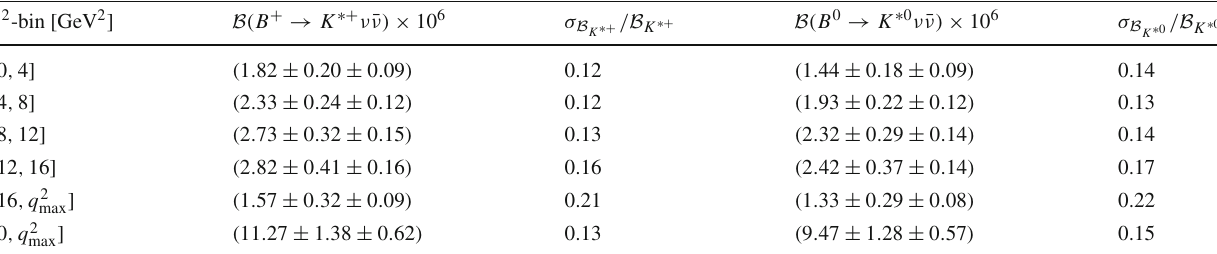
Table 4 SM predictions similar to those presented in Table 3 but for the case of vector meson in the final state, B → K ∗ ν ¯ ν q 2 -bin [ GeV 2